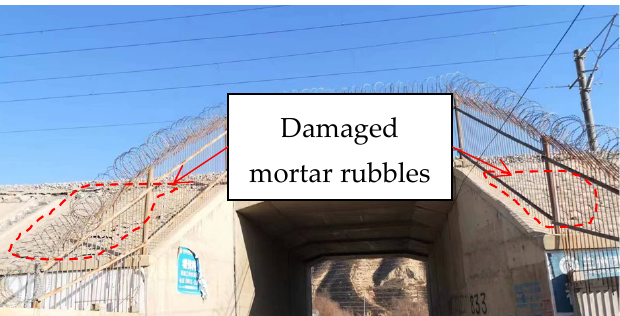
Figure 5. A picture of the damaged mortar rubble in the subgrade–culvert transition section.